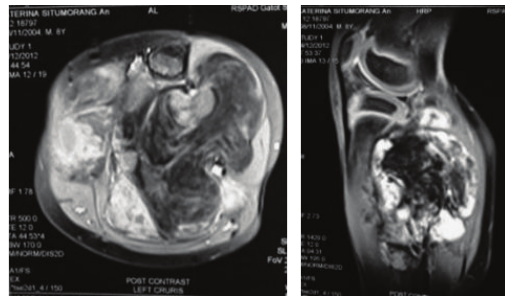
Figure 10: MRI of Case 3. Axial and sagittal view in T1-weighted images with fat saturation and contrast administration. The mass looked more infiltrative to surrounding muscles, with hypointense fatty component and mildly enhanced myxoid